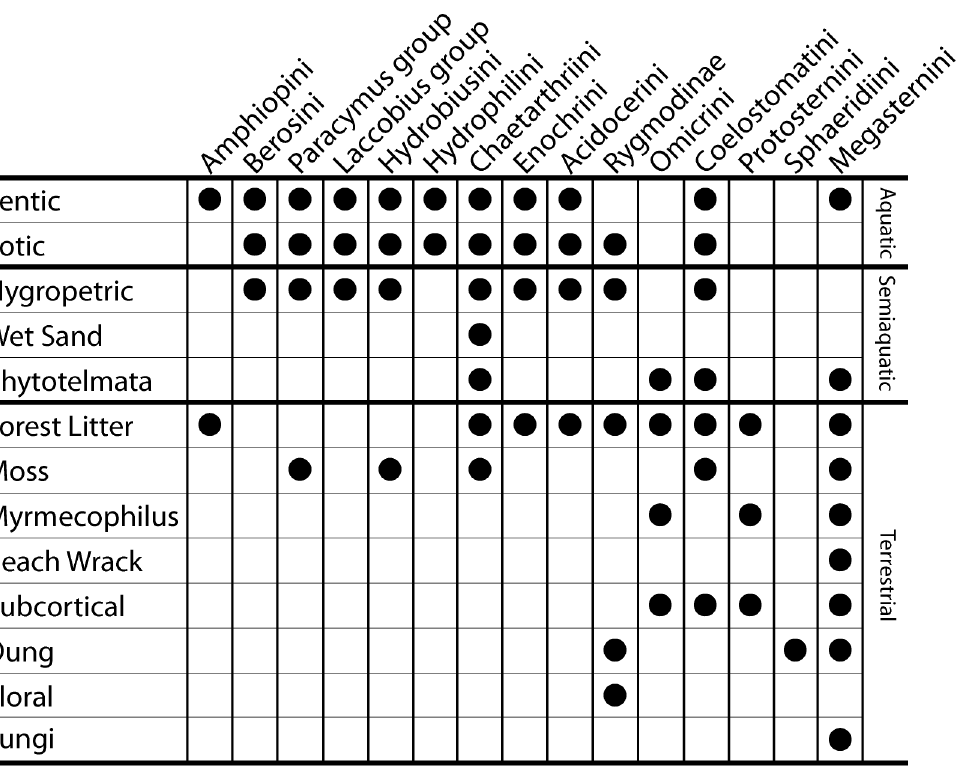
Figure 1. Distribution of habitat types across the major clades of water scavenger beetles.